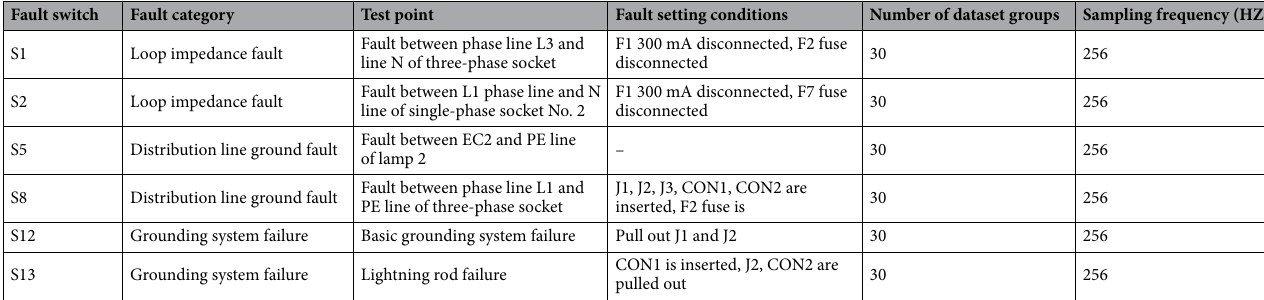
Table 2. Brief introduction of fault settings and